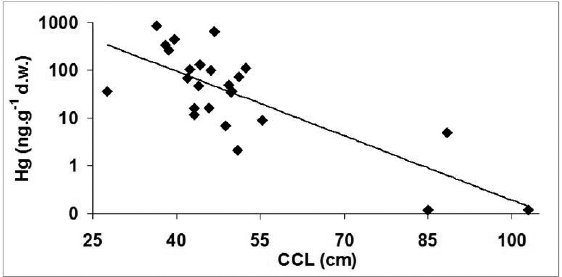
Figure 2. Significant negative correlation (n=25; p<0.01) between total Hg concentrations and curved carapace length (CCL) observed in the sea turtle C. mydas from the Ceará coast in NE